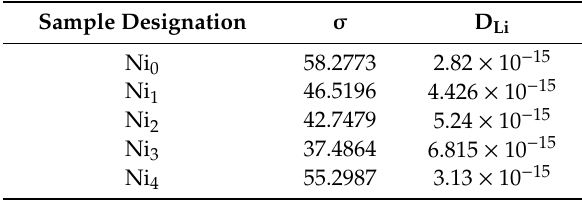
Table 2. σ and D Li values of the